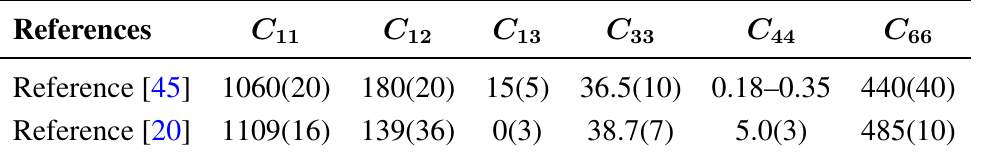
Table 2. Experimental values of the elastic constants of graphite (all data in